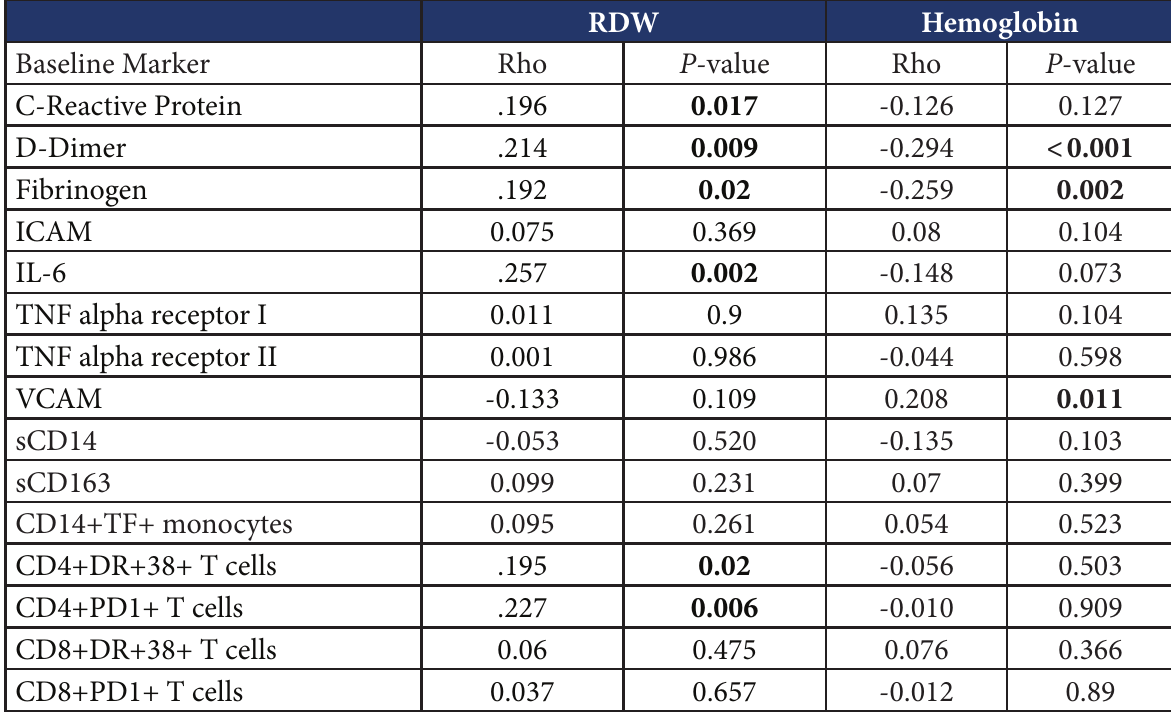
Table 3. Spearman correlations between RDW and hemoglobin with baseline markers of inflam- mation and immune